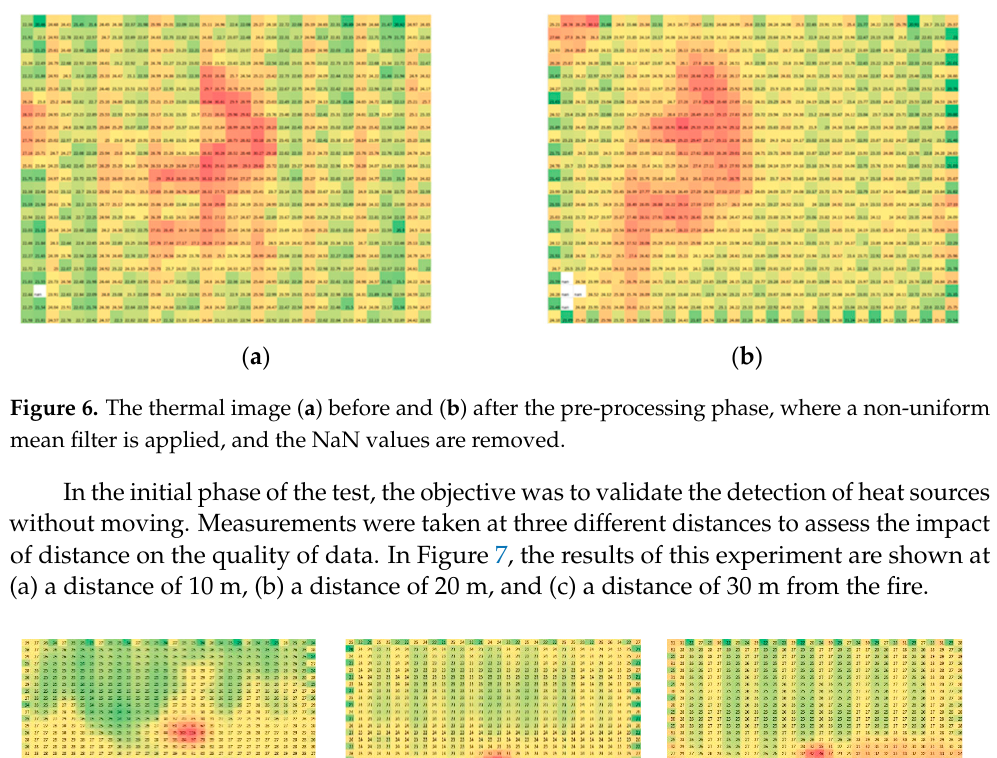
Figure 8. Experiment conducted at a distance of 20 m from the heat source, moving at 30 km/h. Sequence of four images targeting the heat source: 1st (top ‐ left), 2nd (top ‐ right), 3rd (bottom ‐ right) and 4th (bottom ‐ left). The results of this test show that the greater the speed and distance, the more signif ‐ icant the impact on the heat source identification accuracy; nevertheless, it demonstrates that the chosen multi ‐ pixel IR thermal sensor performs well under the test conditions used for the multi ‐ sensor device. Further testing was conducted on the multi ‐ sensor device to assess the proper functioning of the remaining sensors. The last component of its valida ‐ tion was to test the web server that would be created on the ESP32 to provide the sensor